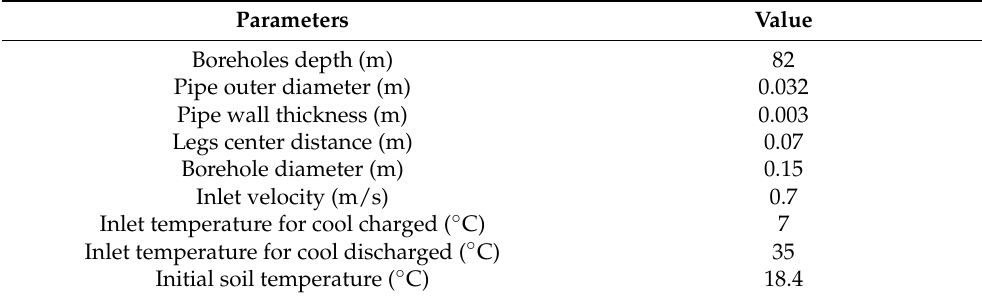
Table 1. Design parameters for the numerical model.